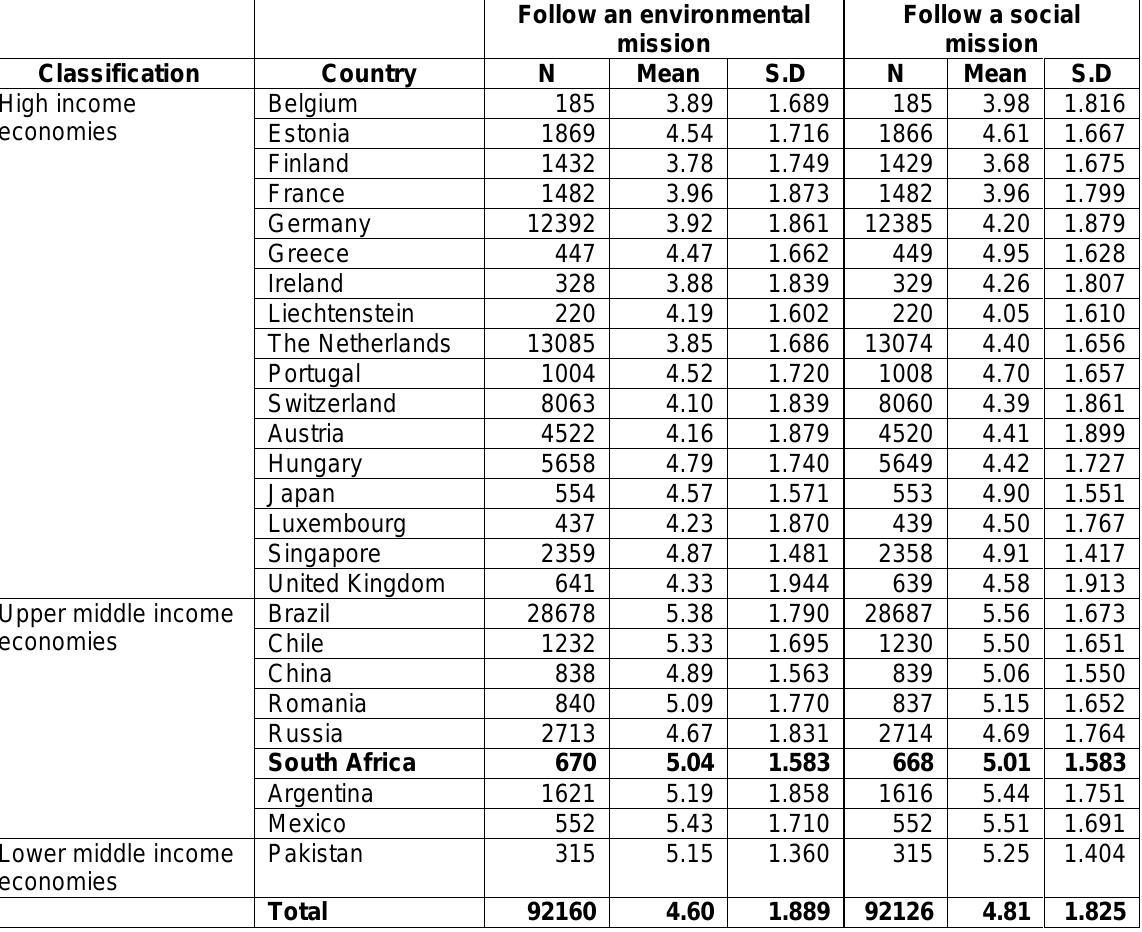
Table 5: Motivation to follow an environmental or social mission per country